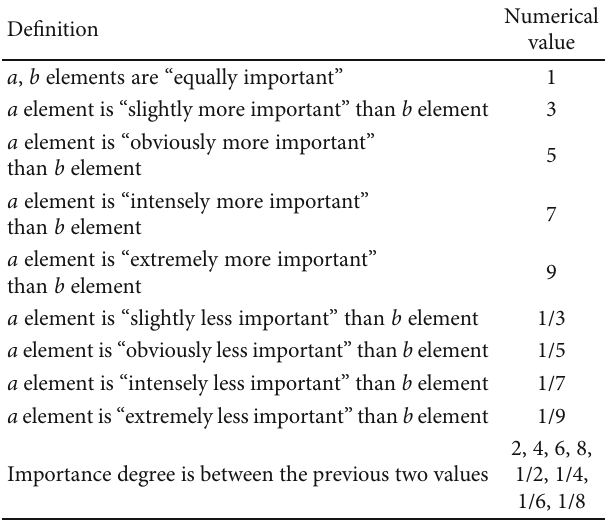
Table 3: Importance between criteria M from Jiang et al. [31]).